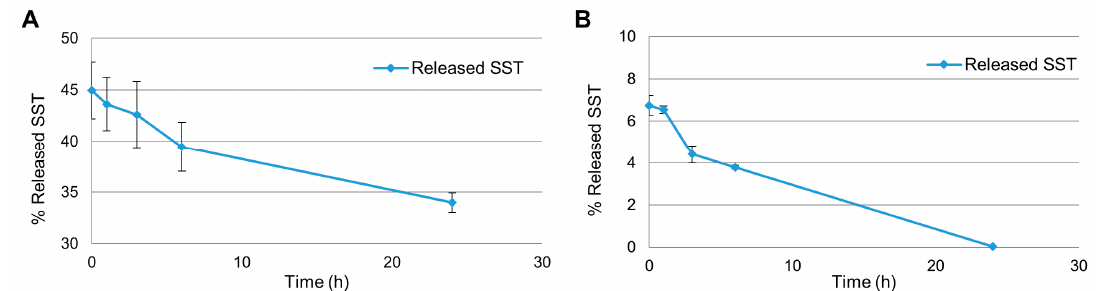
Figure 5. ( A ) Measurement of SST concentration in plasma after reconstituting the NEs directly in plasma (protocol 1). ( B ) Measurement of SST concentration in plasma after removing the non-encapsulated SST fraction (protocol 2). Percentages are calculated from the LC/MS analyses related to the starting concentration of 0.5 mg/mL.